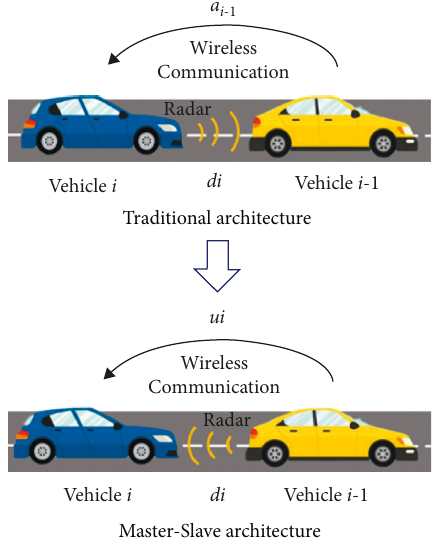
Figure 1: The schematic of traditional architecture and master- slave